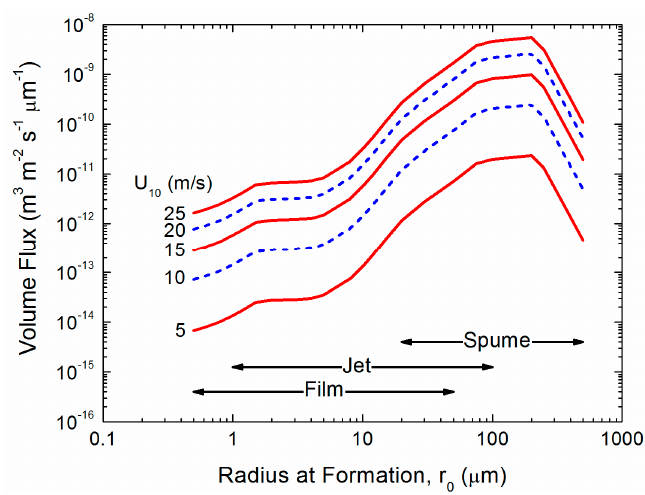
Figure 2. The spray generation function as a volume flux. Andreas [27] formed this function by smoothly joining the relation that Monahan et al. [41] deduced from spray created from bursting bubbles (film and jet droplets) with the relation from Fairall et al. [8], which is a reasonable function for the larger (spume) droplets [42].